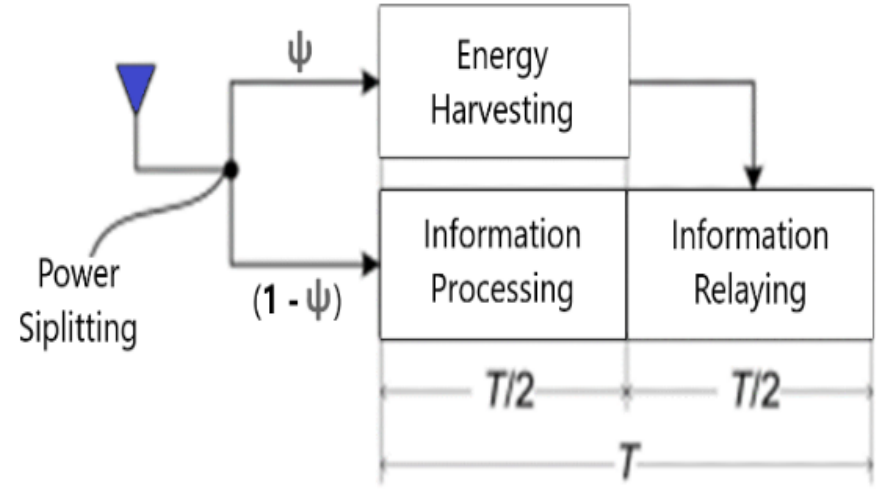
Figure 1. SWIPT with DF-relayed NOMA.